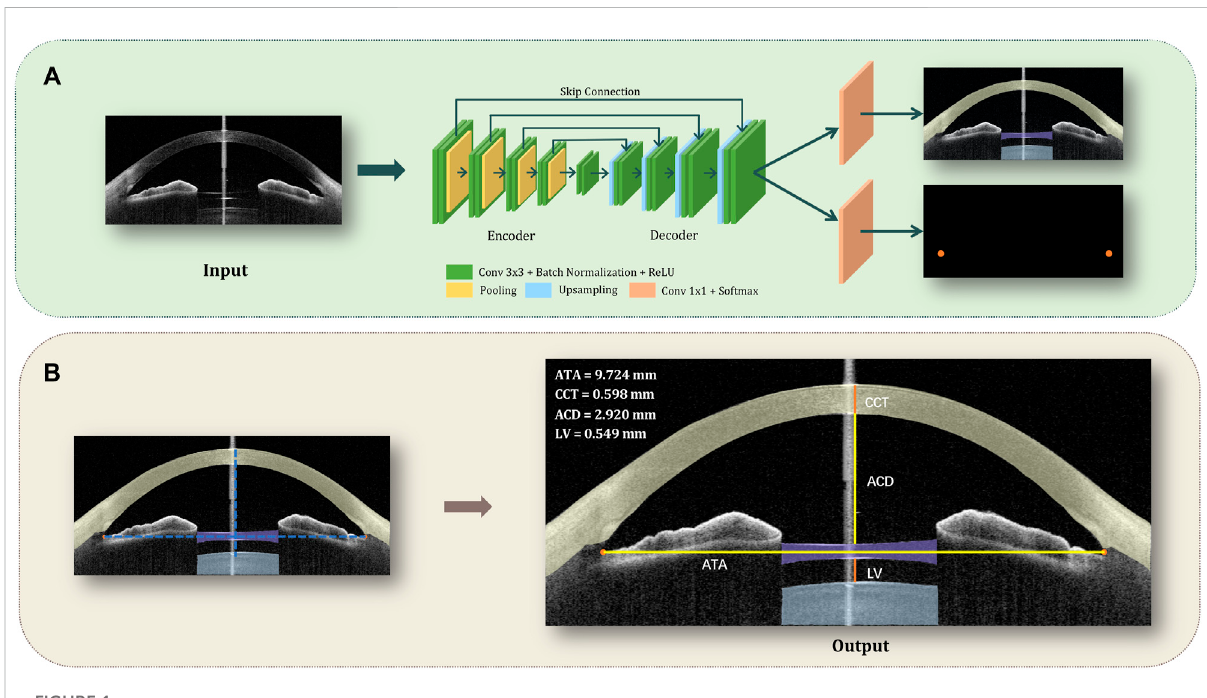
FIGURE 1 Flowchart of the deep learning system, whichis able to monitor the ICL position and recognize subtle alterations in the anterior chamber using AS-OCTimagesforpatientswithICL. (A) .Thedetection approach:eachAS-OCTimagewasmanuallysegmentedinto5parts(thecorneosclera,ICL, lens,andangle recesspoints forbothleftandright)andput intoanimprovedU-Netarchitecture forthetraining process.Then, thetestimages went throughthedetection approach togeneratethesegmentationmap. (B) .Thequanti fi cationapproach:thecentroidofthemaximumconnected area of the angle recess area was calculated and de fi ned as the fi nal coordinate of the points. Then we connected the left and theright angle recess, and make the perpendicular bisector of ATA, which represents the line of axis oculi. Afterward, the intersections of the contour and the axis oculi were connected to calculate CCT, ACD, and LV